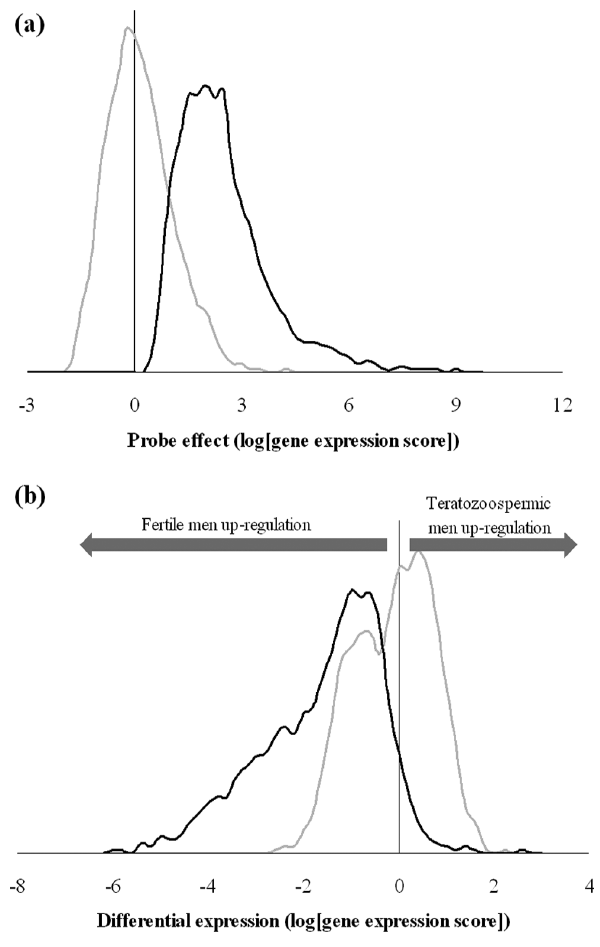
Figure 1. Distribution of mean estimates for probe ( a ) and differential expression within-probe ( b ) effects under Model SG (grey line) and Model AT (black line) for data set 3. doi:10.1371/journal.pone.0038919.g001 PLoS ONE |